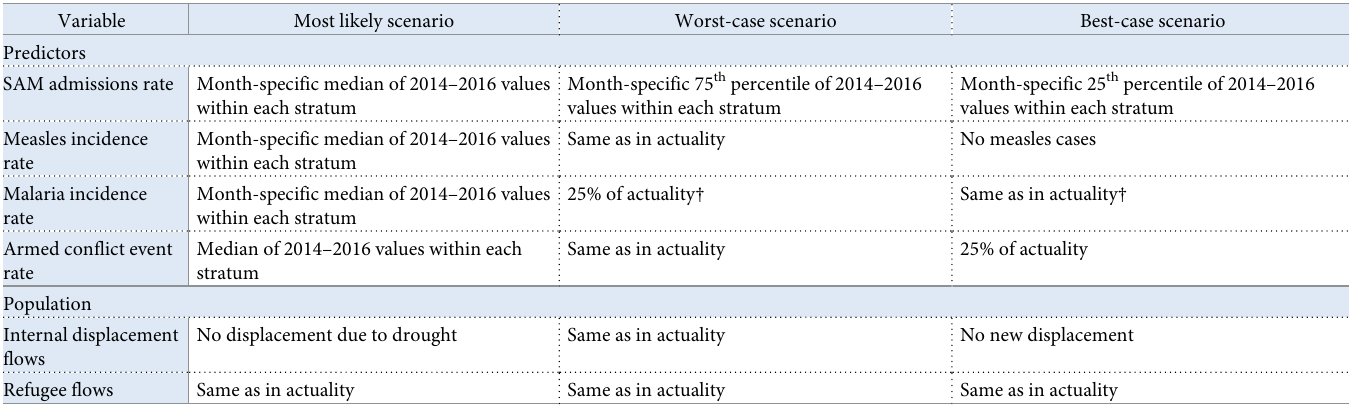
Table 2. Most likely, reasonable worst-case and best-case counterfactual